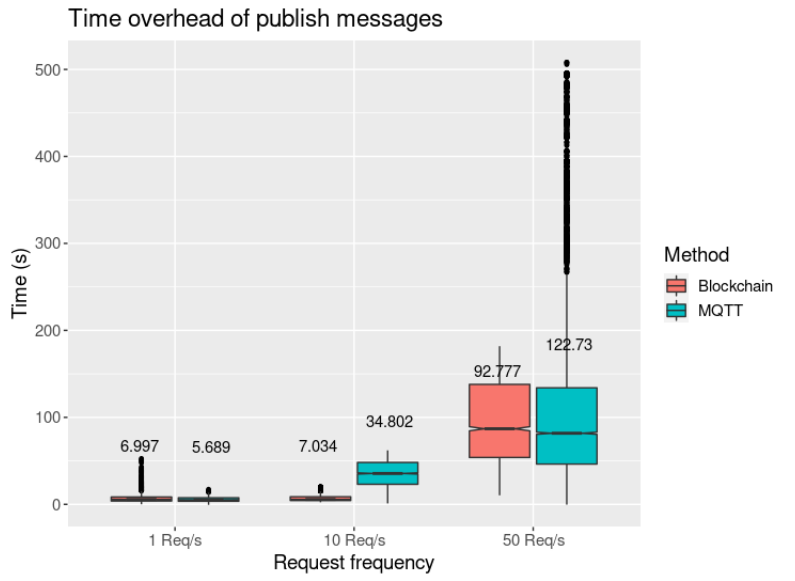
Figure 9. Time overhead measured in the sensor controller with mean values.